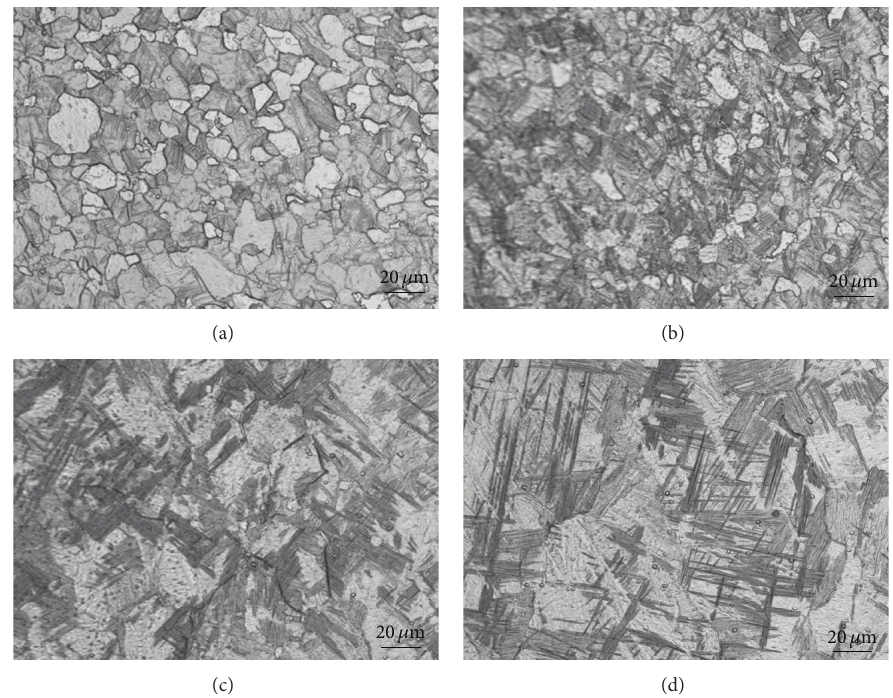
Figure 13: Optical microstructures of TA15 alloy deformed under different conditions: (a) 𝑇 = 1203 K, ̇𝜀 = 0.005 s; (b) 𝑇 = 1203 K, ̇𝜀 = 0.05 s −1 ; (c) 𝑇 = 1223 K, ̇𝜀 = 0.05 s −1 ; (d) 𝑇 = 1273 K, ̇𝜀 = 0.05 s −1